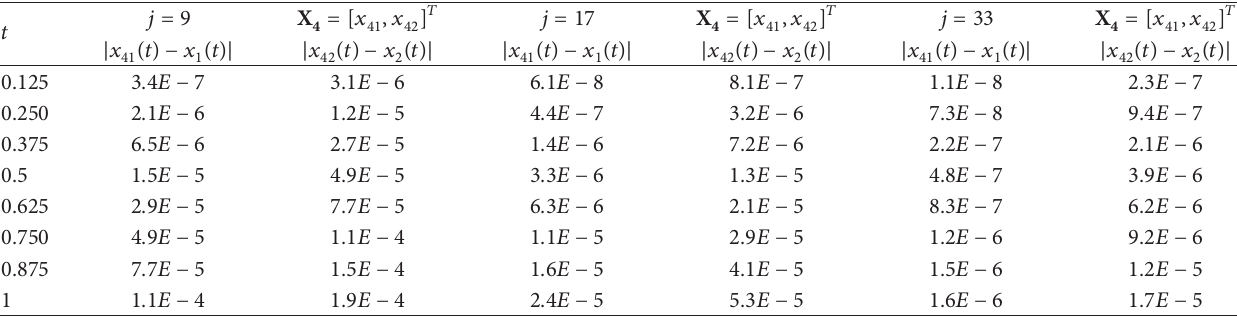
Table 5: Absolute errors for Example 5.